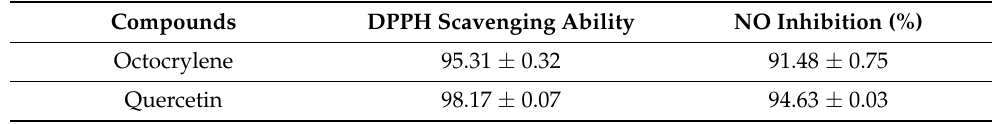
Table 4. Free radical scavenging activity of the identified